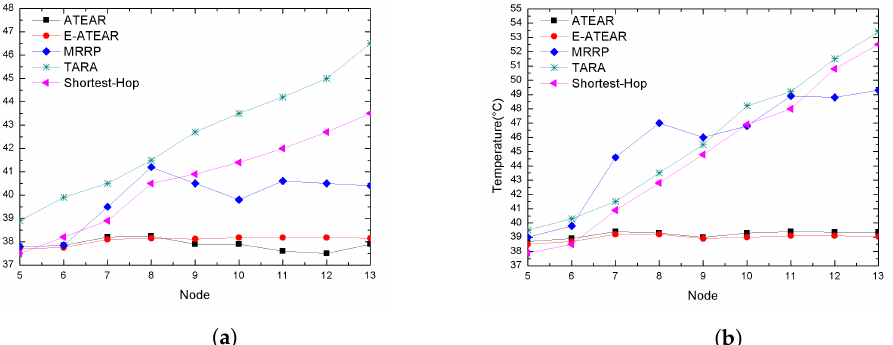
Figure 9. Average temperature rise consumption with different node density. ( a ) Simulation time = 300 s; ( b ) simulation time = 1000